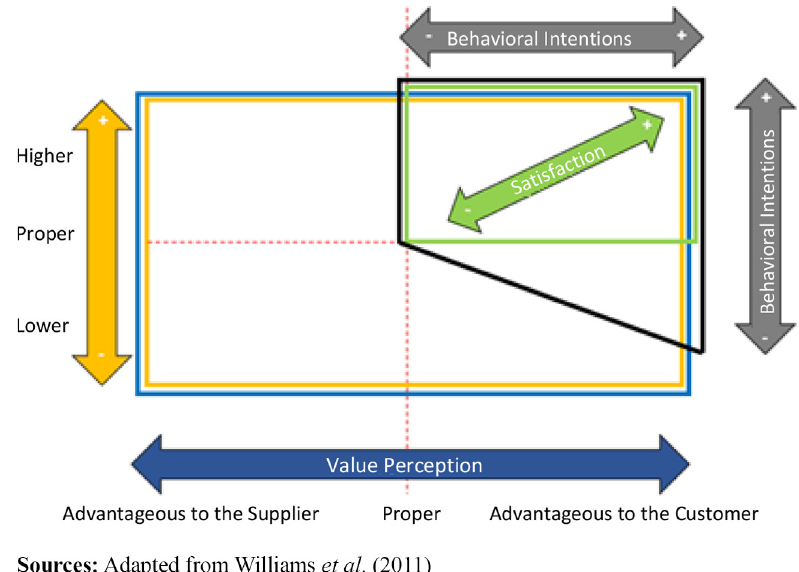
Figure 1. Buyers (customer) ’